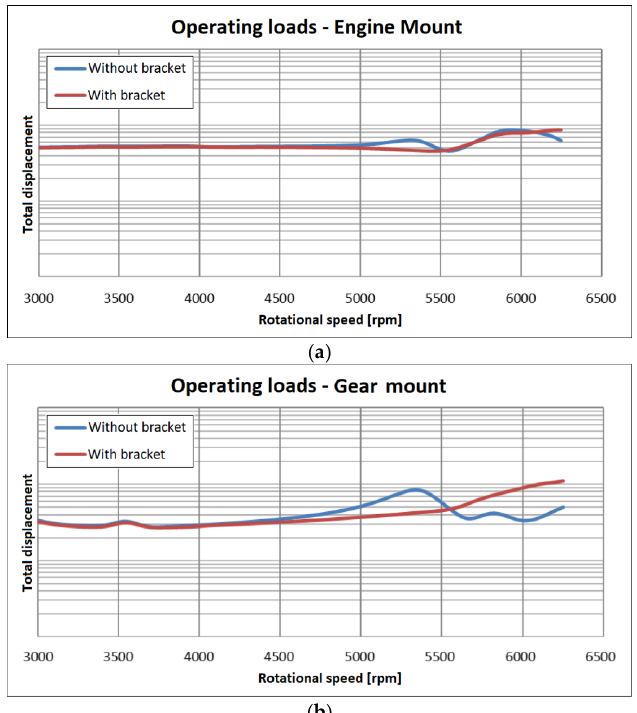
Figure 7. Displacement magnitude calculated at the ( a ) engine and ( b ) gear mounts considering the realistic operating loading condition.